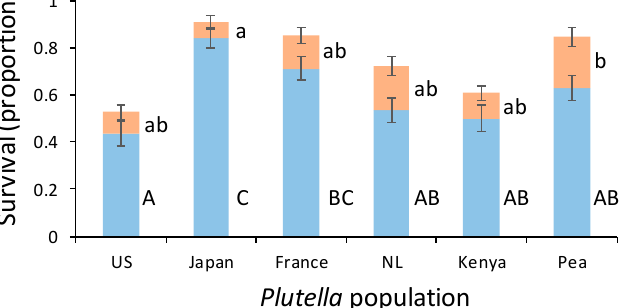
Figure 3. Survival to adulthood (blue bars: mean proportion ± SE) of Diadegma semiclausum from Plutella xylostella host populations originating from the US, Japan, France, the Netherlands (NL), and Kenya, as well as a population adapted to pea in Kenya. Orange bars present the proportion D. semiclausum cocoons that did not emerge as adults. Orange (small letters) and blue bars (capital lettes), respectively, with the same letter are not significantly di ff erent. For each population, 11 parasitized caterpillars were introduced on each of 10 Brassica rapa plants.